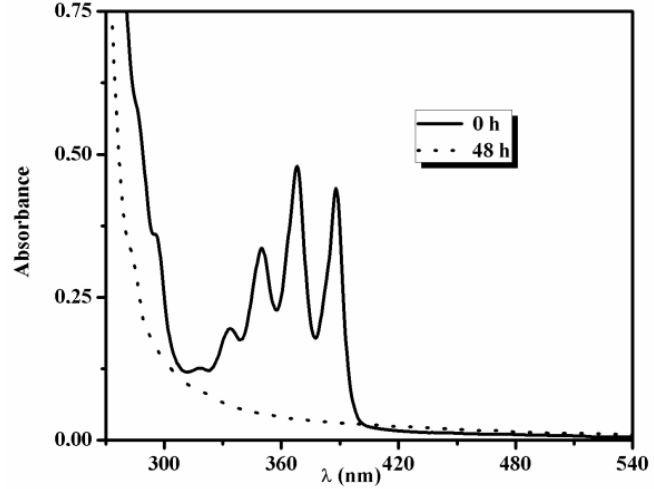
before and after reacting with PEG-MI under standard 2 = 1.48 × 10 − 6 mol/L in CH 0